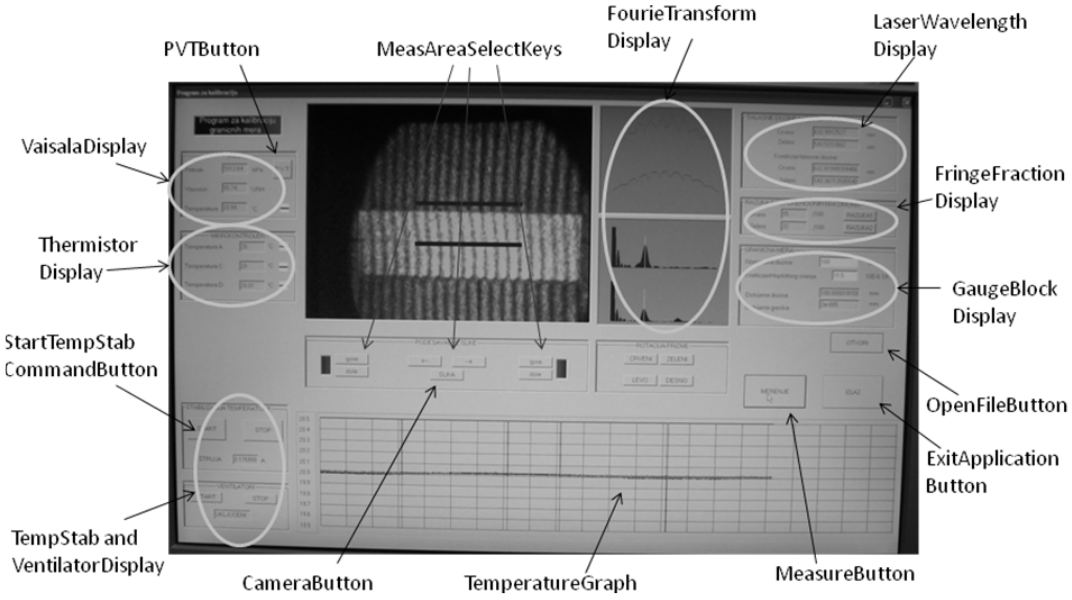
Fig. 4. The interferometer software